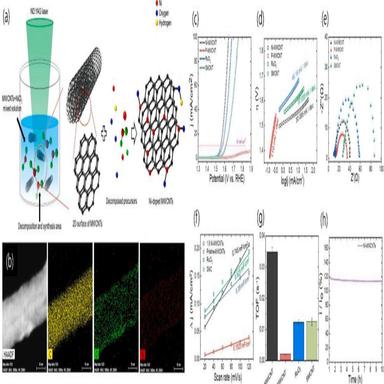
(a) Schematic illustrations of the mechanism for Ni-doped multi-walled carbon nanotubes (Ni-MWCNTs). (b) Elemental mapping image for C, O, and Ni in asprepared Ni-MWCNT. (c, d) Oxygen Evolution reaction (OER) polarization curves (scan rate 5 mVs− 1 ) and corresponding Tafel plots in 1.0 M KOH solution. (e) Electrochemical impedance spectroscopy (EIS) plots. (f) Current difference between anodic and cathodic sweeps as a function of scan rate. (g) Turnover frequency (TOF) at an overpotential of 320 mV. (h) Cy